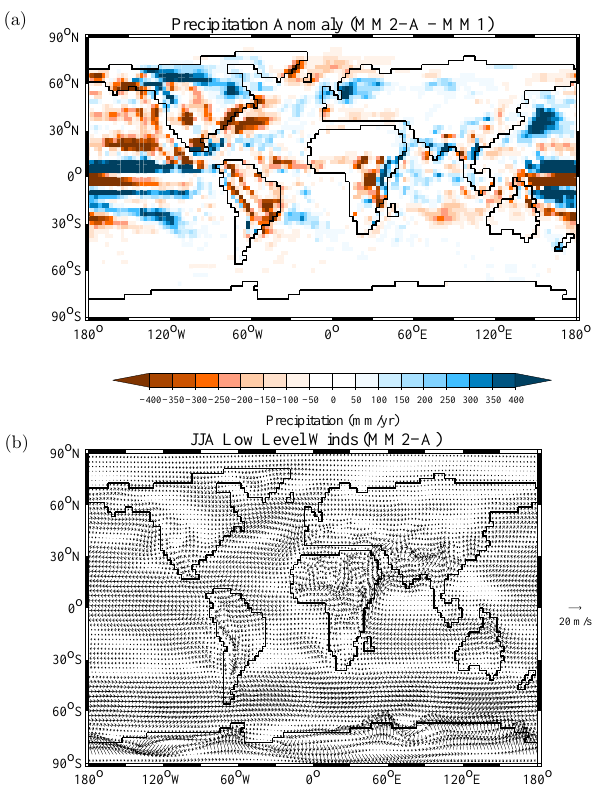
Fig. 13. Same as Fig. 12 for experiment MM2-A that considers a reduced topography only in North America.